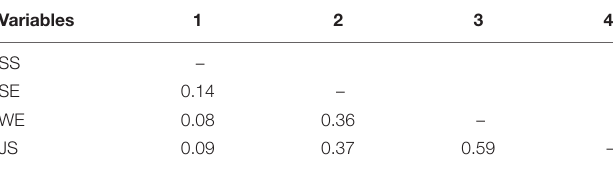
TABLE 5 | Heterotrait–monotrait (HTMT) discrimination validity.